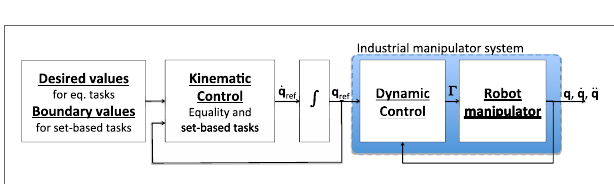
FIGURE 4 | The control structure of the experiments . The tested algorithm is implemented in the kinematic controller